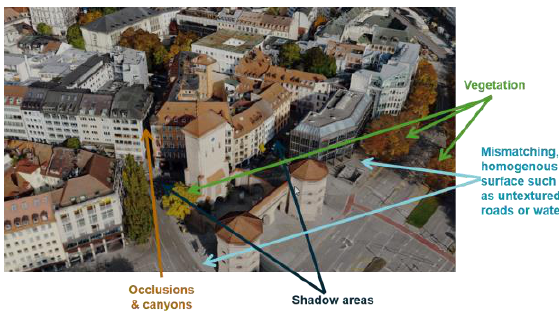
Figure 13: Advantage of LiDAR for 3D Mesh